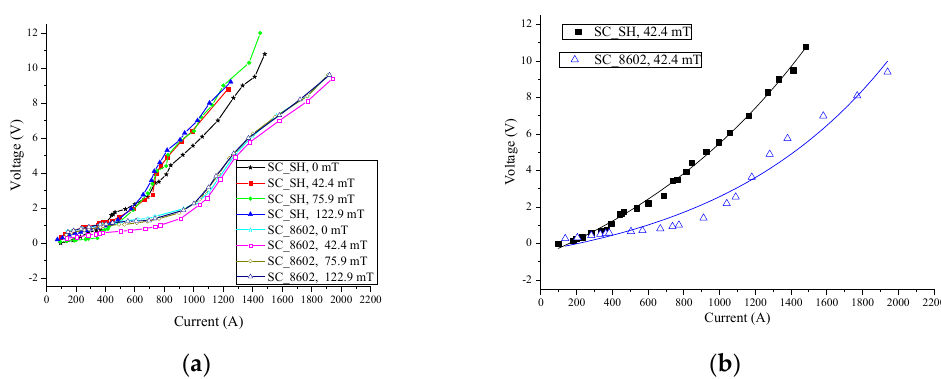
Figure 8. The effects of transport current on the voltage of the tapes. ( a ) The effects of transport current on the voltage at different TMF. ( b ) 4.5 mT.